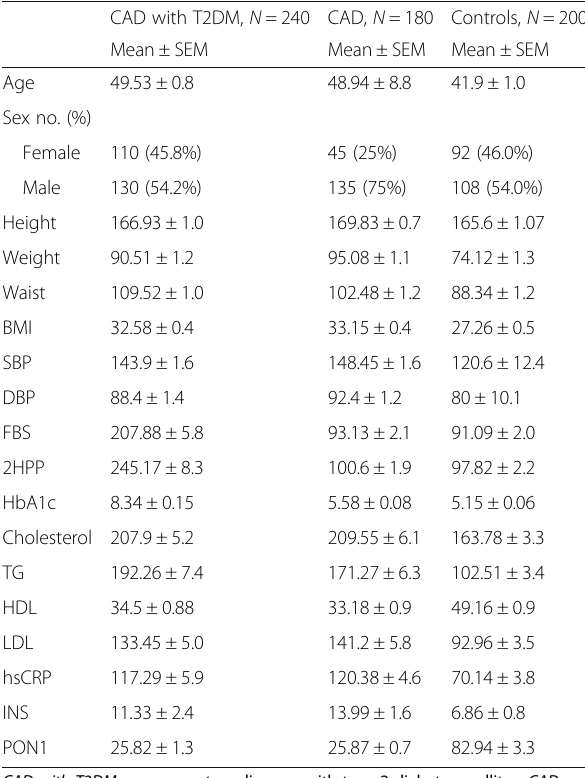
Table 1 Demographic and biochemical variables of the study populations